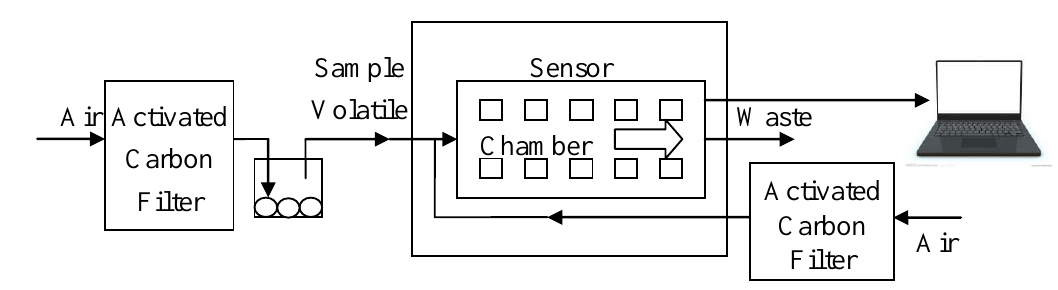
Figure 2. The structure of the portable electronic